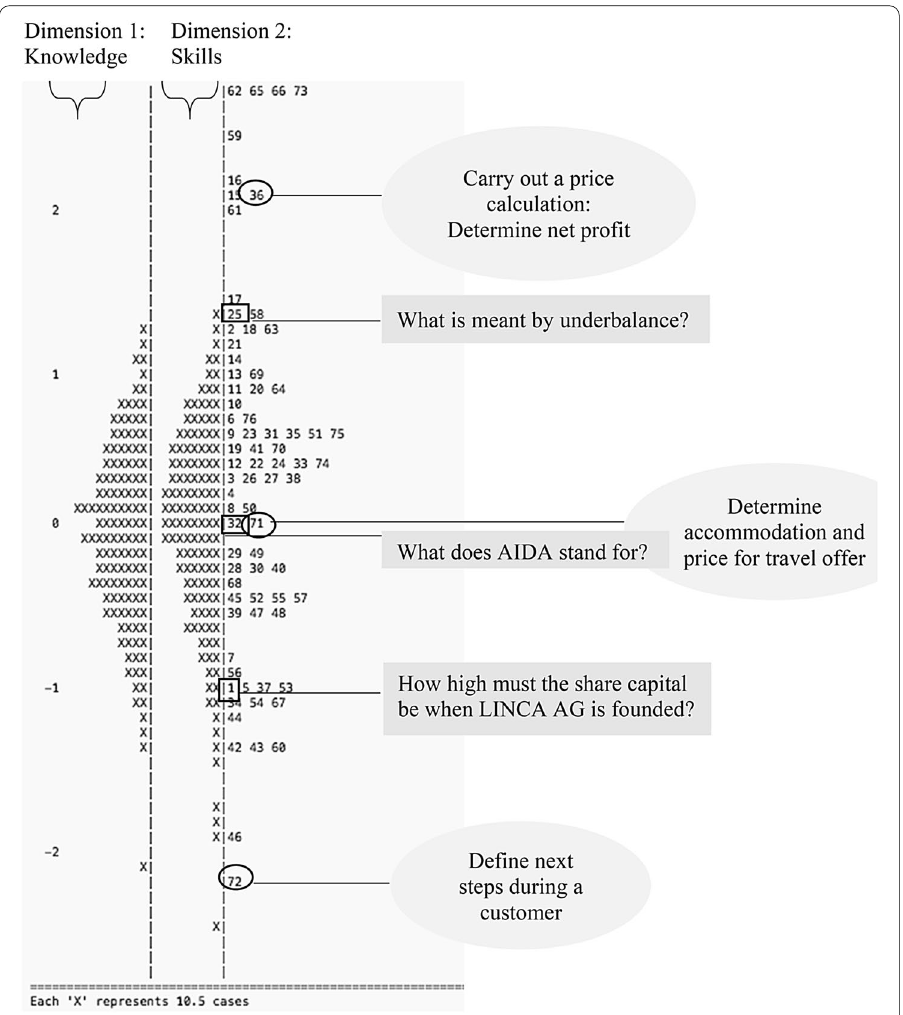
Fig. 1 Wright Map of the two‑dimensional model. Items 1–33 belong to the first dimension [1–25 are dichotomous, 26–33 are partial credit]. Items 34–76 belong to the second dimension [34–49 are dichotomous, 50–76 are partial credit]). Ovals items for knowledge‑based